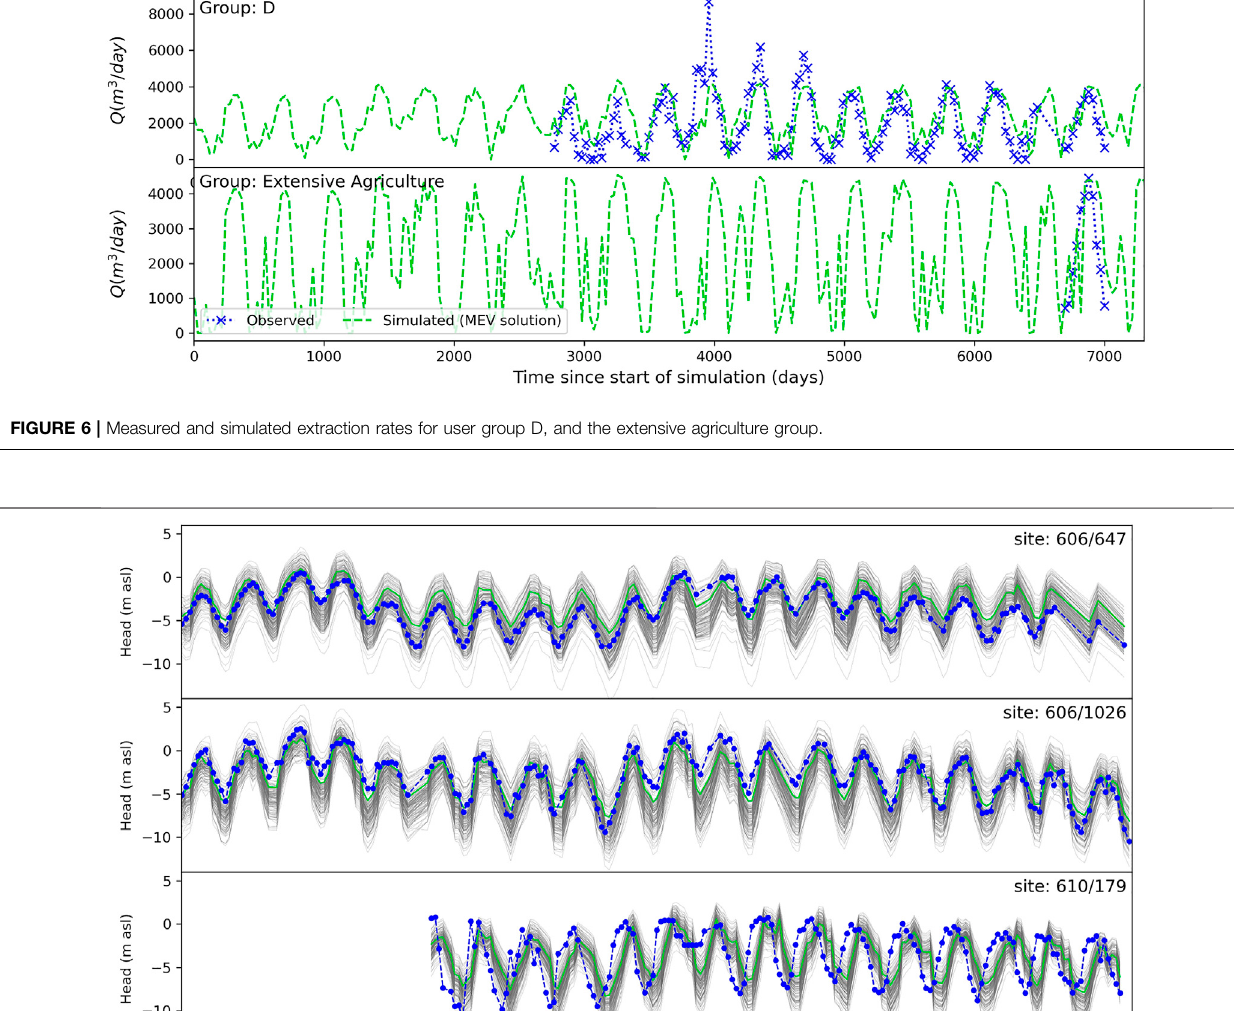
extractions well, particularly in the central and eastern parts of the model.